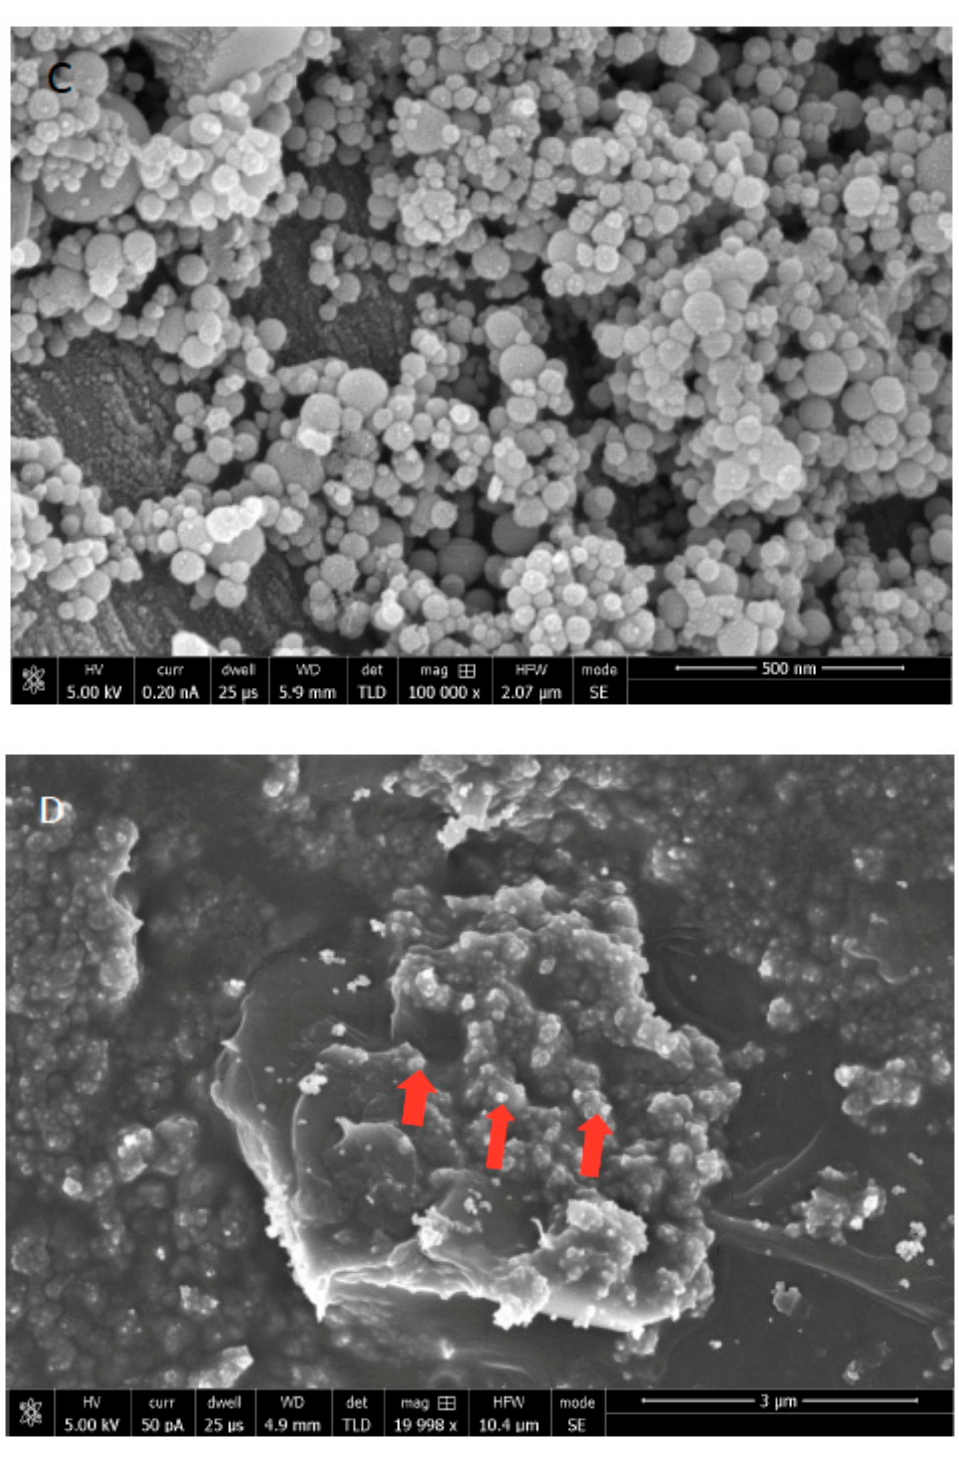
Figure 1. SEM images of ( A ) synthesized graphene oxide (GO) nanoparticles. Graphene oxide showing variable size flakes with 1–2 nm thickness. ( B ) Hydroxyapatite (HA) nanoparticles with <100 nm in size. These nanoparticles on SEM showing uniform round agglomerated structures. ( C ) Low magnification of composite structure of GO-HA, where HA nanoparticles were coated over reduced GO (white arrowhead). ( D ) High magnification of a single GO nanoparticle showing uniform distribution of HA (red arrowheads) over its surface.